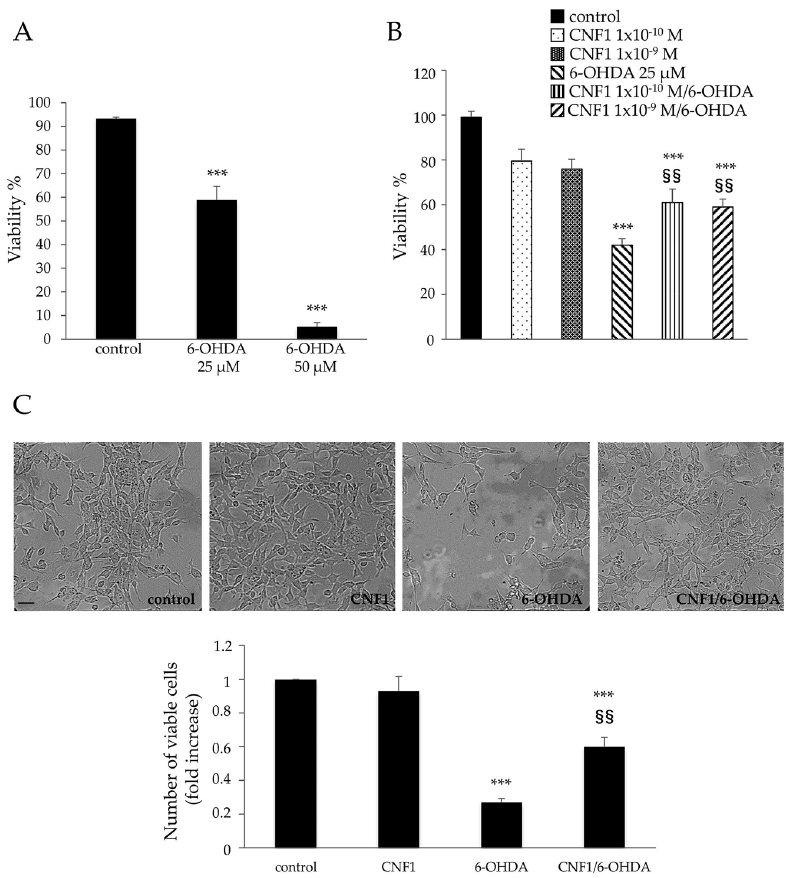
Figure 1. Cytotoxic necrotizing factor 1 (CNF1) partially rescues cell viability in SH-SY5Y